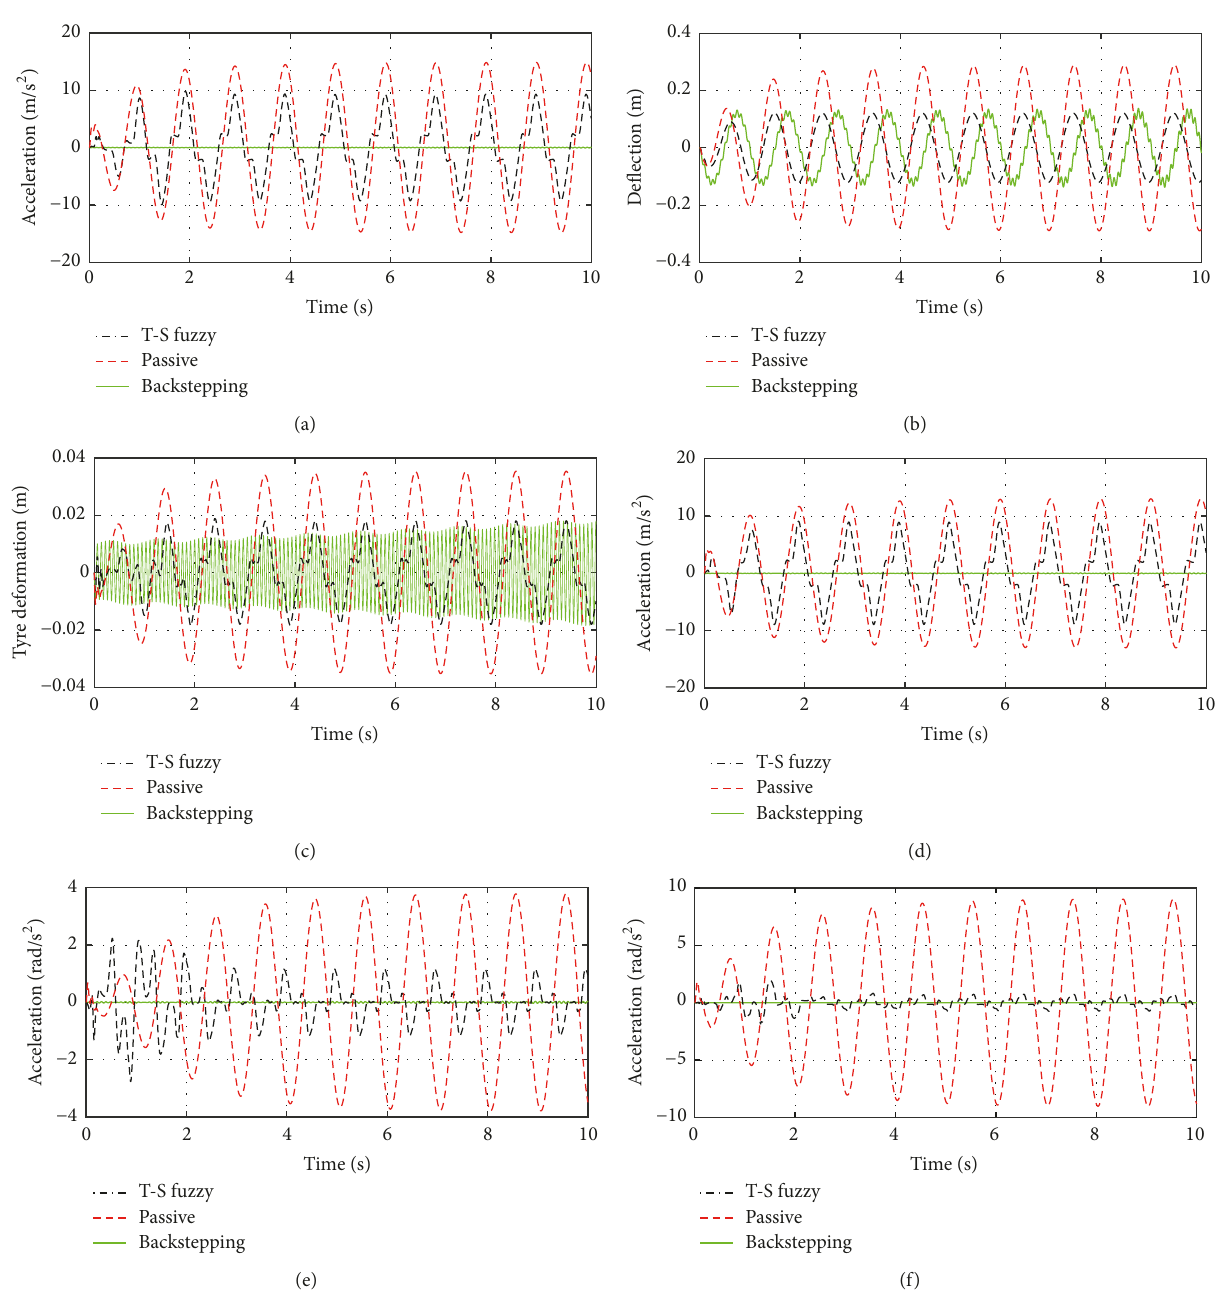
Figure 4: Output response for a malevolent road perturbation (0.12m): (a) acceleration response of front right corner; (b) dynamic deflection of front right corner; (c) tyre deformation of front right corner; (d) acceleration response of the center of mass; (e) acceleration response of the pitch motion; (f) acceleration response of the roll